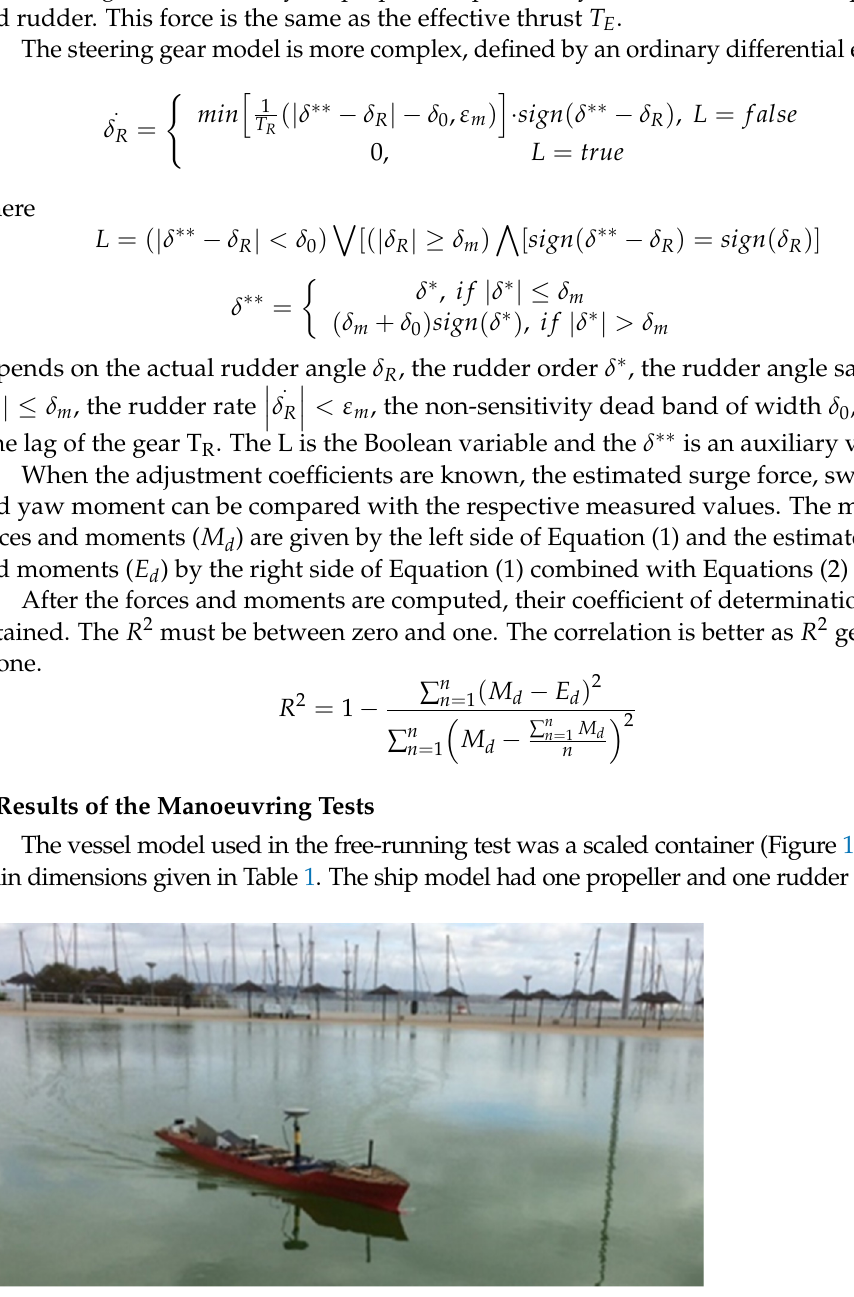
Figure 1. The free-running ship model during the manoeuvring tests. Table 1. Main dimensions of the container model.